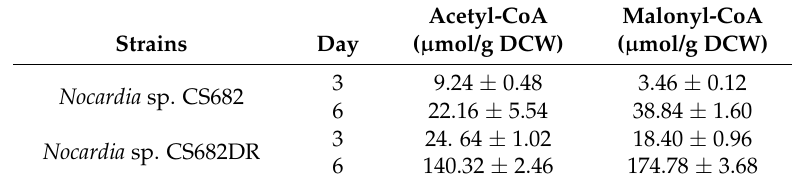
Table 4. Analysis of acyl-CoA extracted from Nocardia sp. CS682 and Nocardia sp. CS682DR.